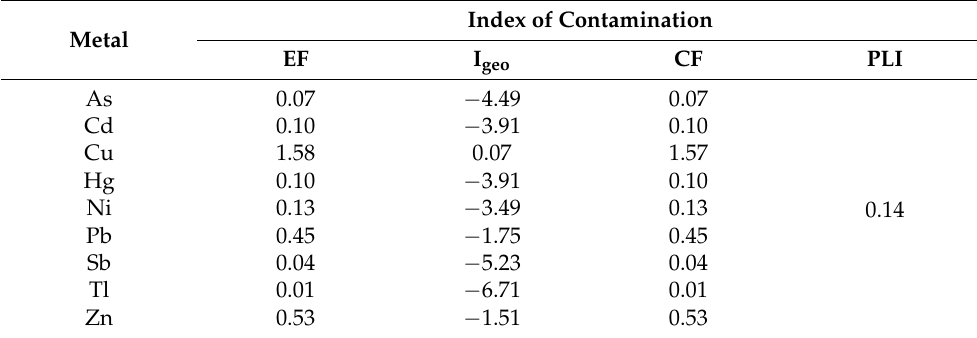
Table 4. Calculated values of EF, I geo , CF and PLI for the investigated